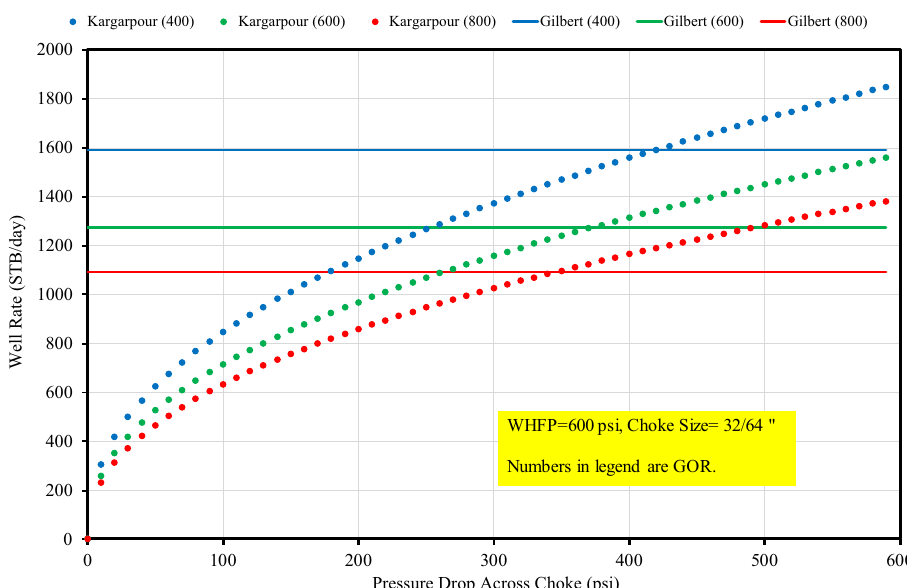
Fig. 6 Comparison of new choke formula with that of